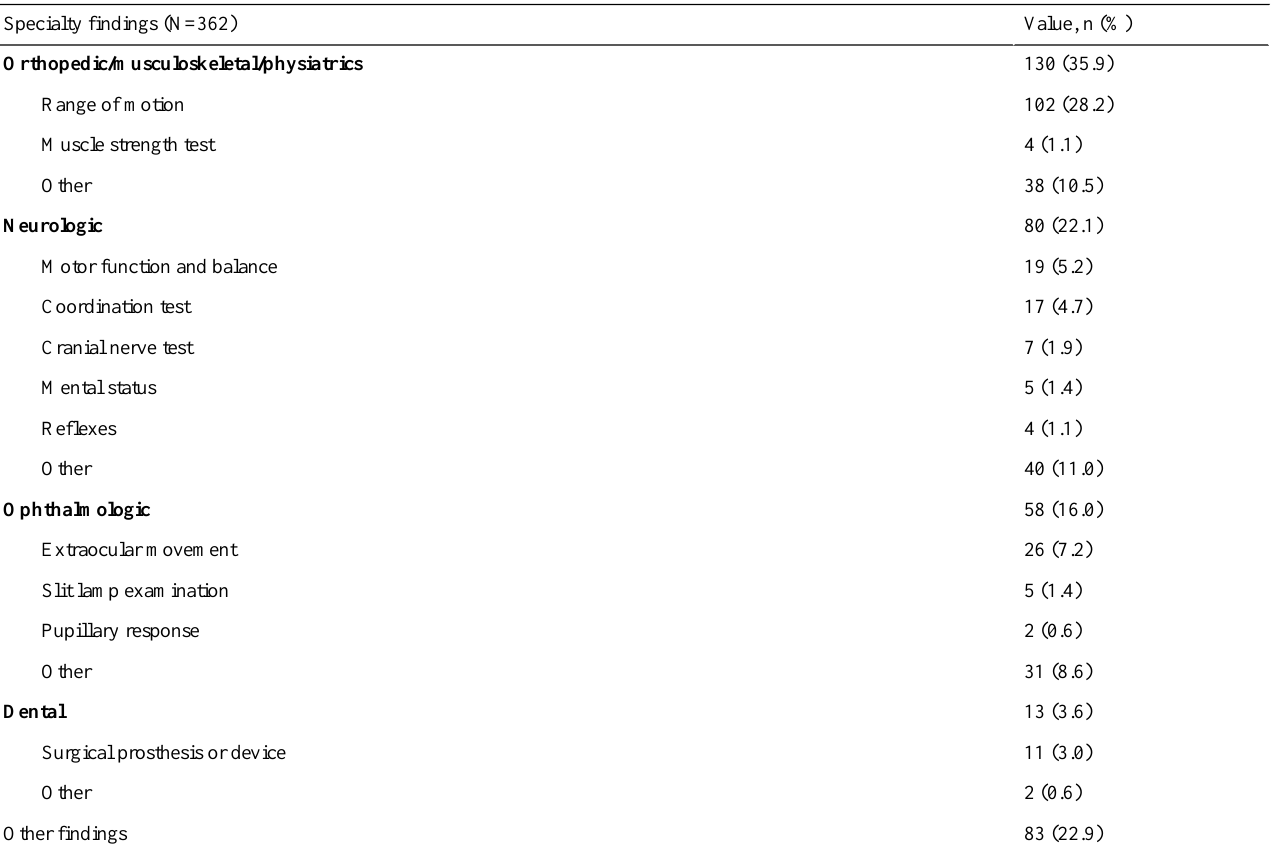
Table 3. Specialty-specific findings included in the video